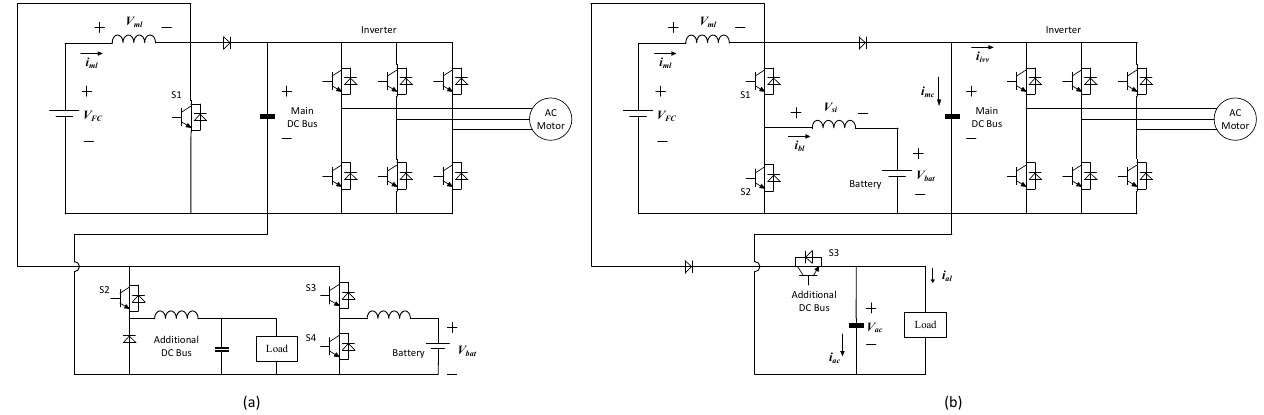
Figure 7. Topology of a hybrid fuel cell with two DC buses: ( a ) conventional structure for a light fuel cell vehicle with an additional DC bus; ( b ) proposed system configuration of the BLDC motor-driven light fuel cell electric vehicle.